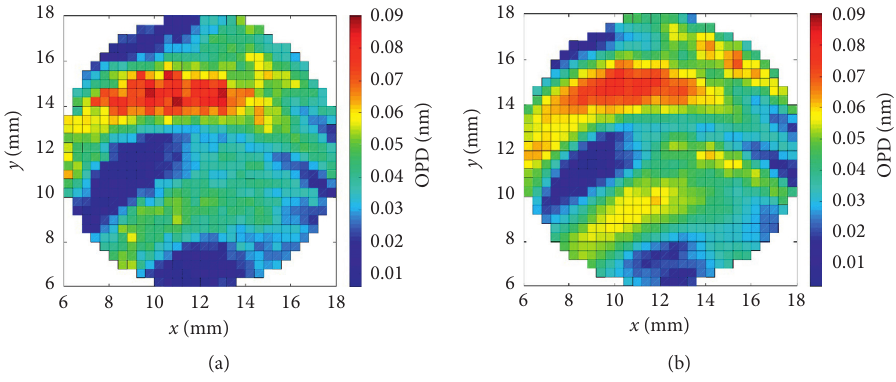
Figure 12: Stress birefringence comparison of fused silica substrates. (a) CRV. (b) PEM [44]. Table 1: Comparison between different